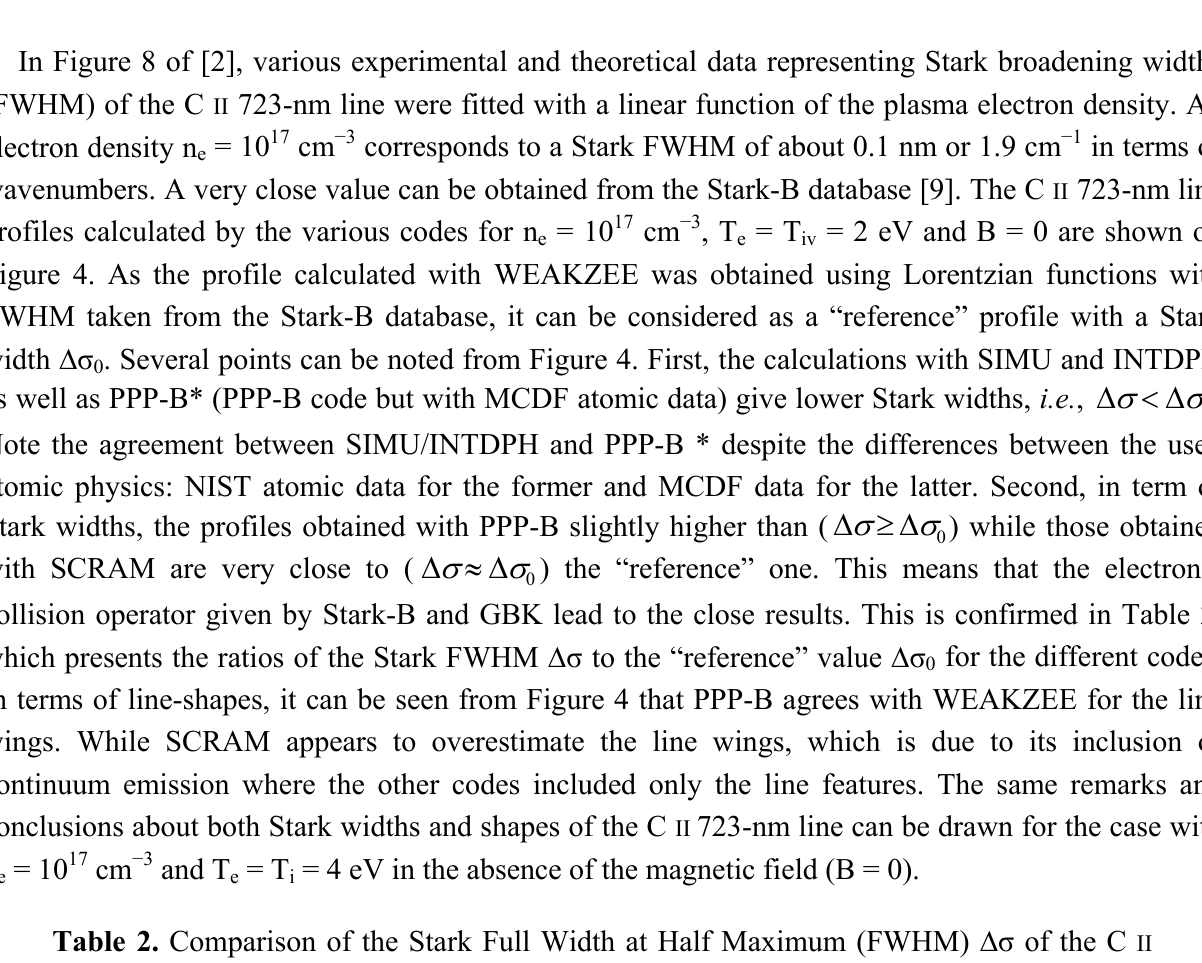
Table 2. Comparison of the Stark Full Width at Half Maximum (FWHM) ∆σ of the C II 723 nm line extracted from the profiles synthetized by the different codes with respect to